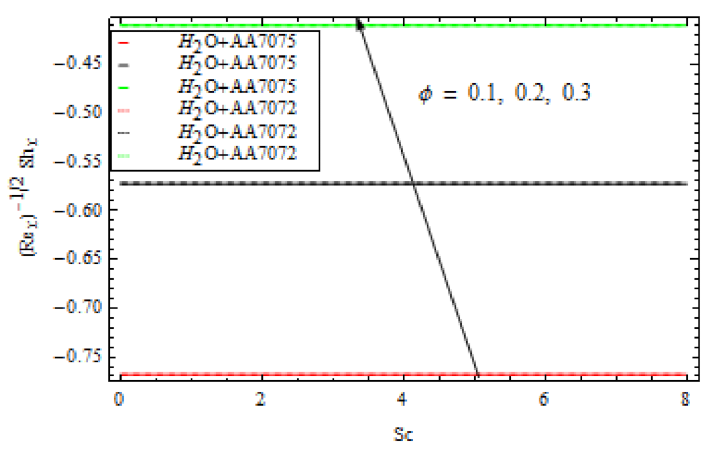
Figure 20. Various values of φ versus